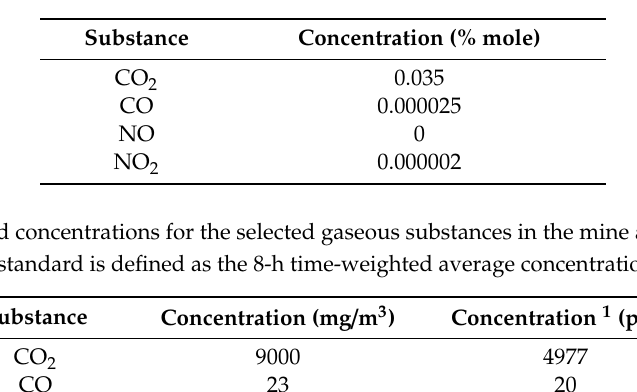
Table 1. Concentrations of the selected substances in clean air [23].